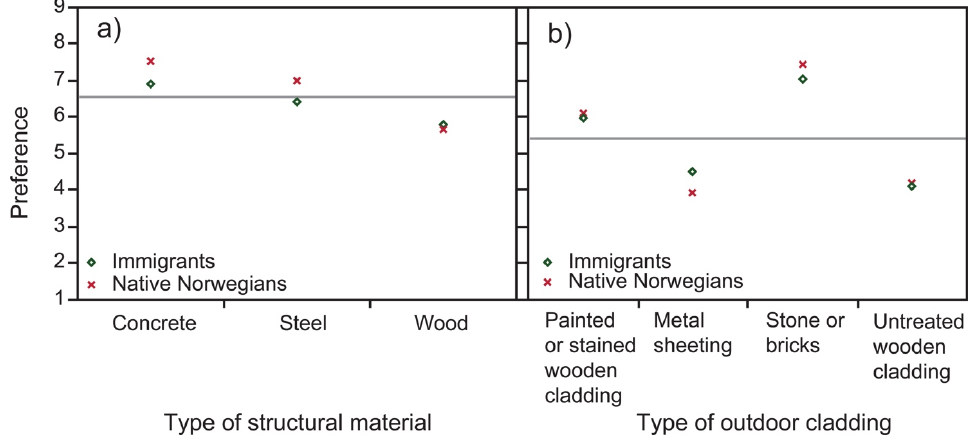
Figure 2. Mean preferences for different structural materials ( a ) and cladding materials ( b ).